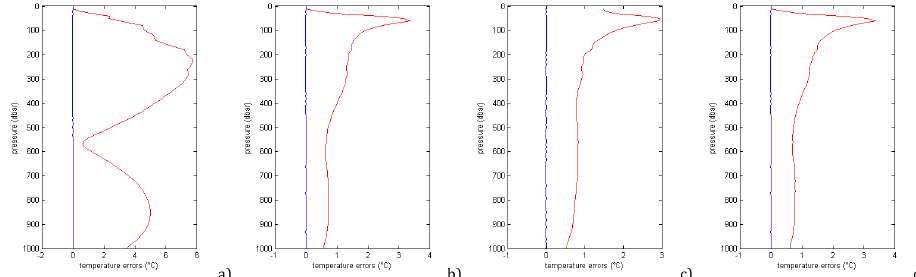
Fig. 2a. Hindcast temperature mean bias errors (blue) and standard deviation errors (red) for different configurations of the mEOF-r technique (see text for the details): (a) mEOF-r( T - S -SH), (b) mEOF-r( T - S -SH) SST-SSH , (c) mEOF-r( T - S -SH) SSS-SSH and (d) mEOF-r( T -SH).